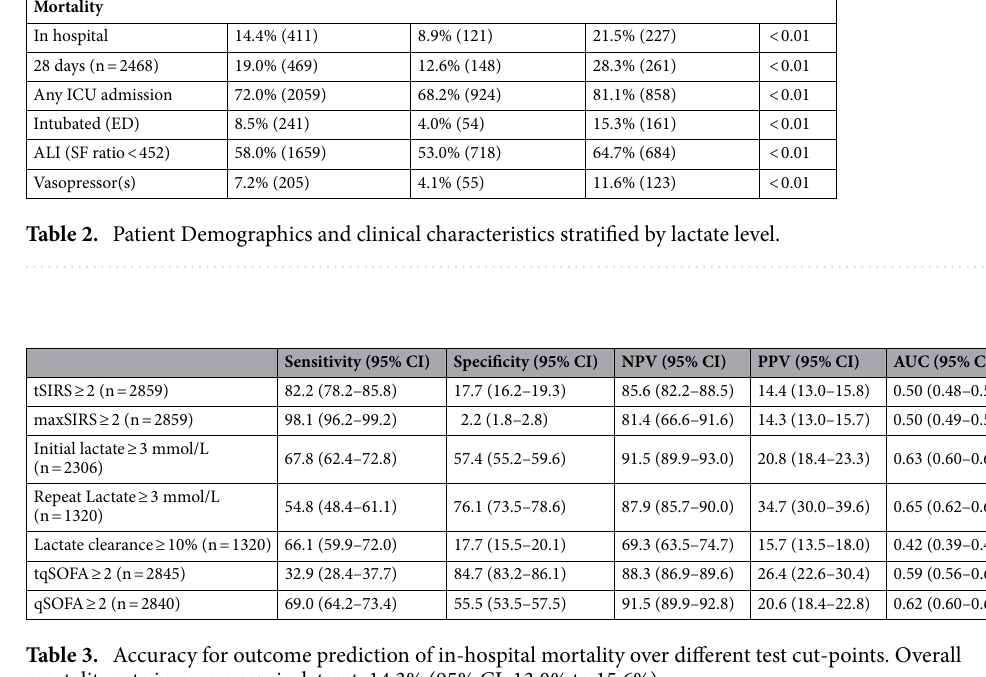
Table 3. Accuracy for outcome prediction of in-hospital mortality over different test cut-points. Overall mortality rate in severe sepsis dataset: 14.3% (95% CI: 13.0% to